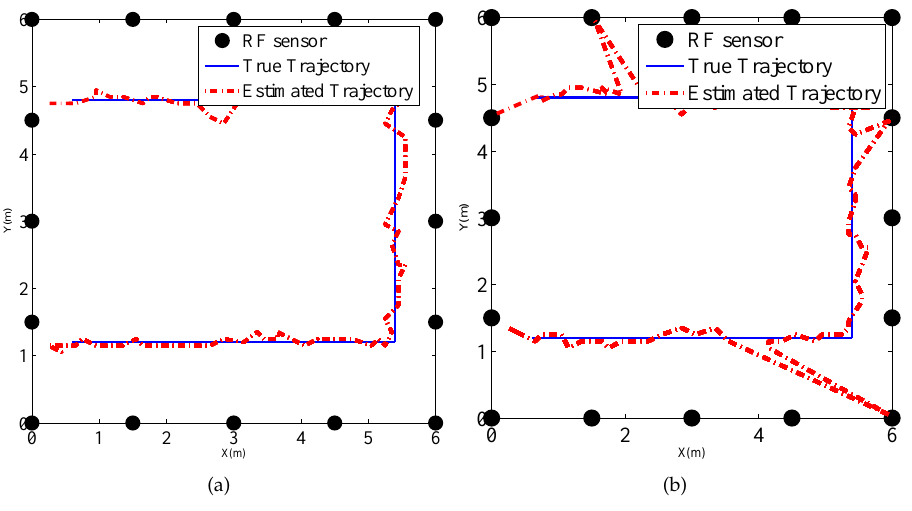
Figure 16. The localization result of ( a ) RTI; and ( b ) GML method.